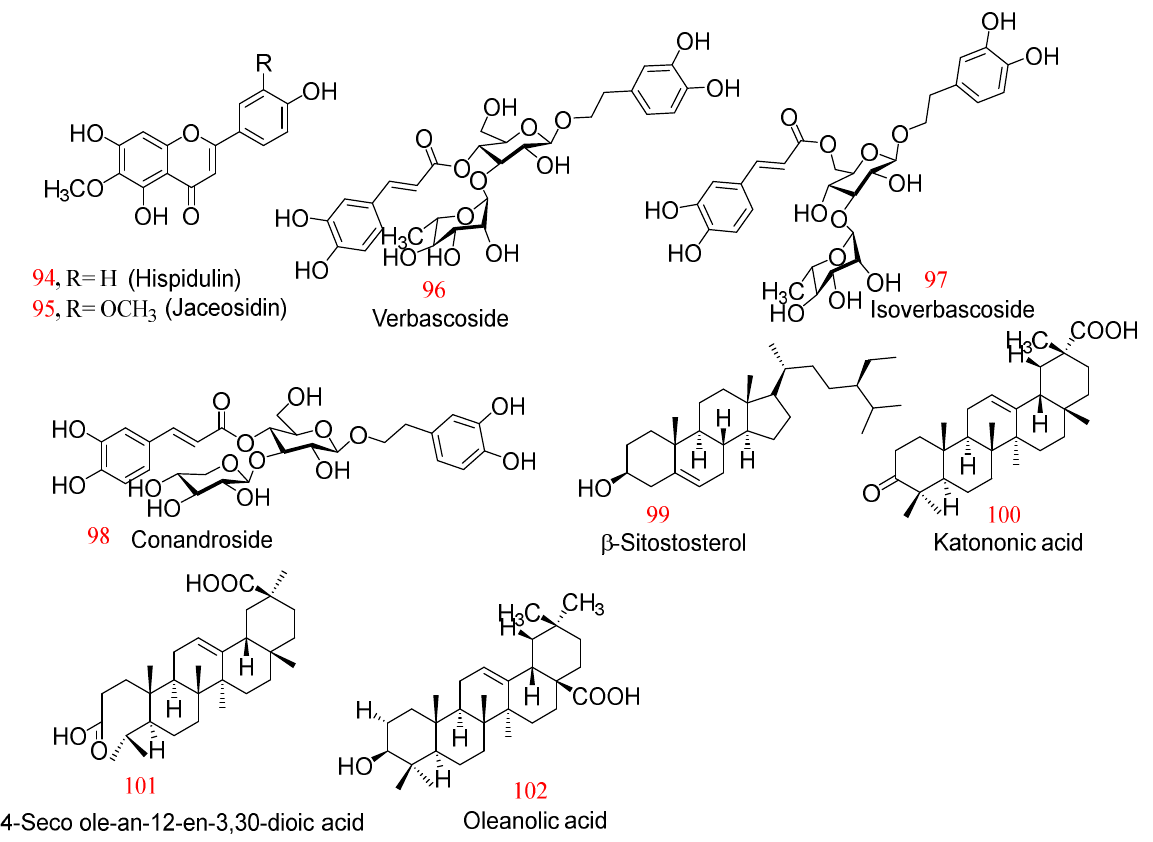
Figure 5. Structures of compounds 19–102 with different biological activities.